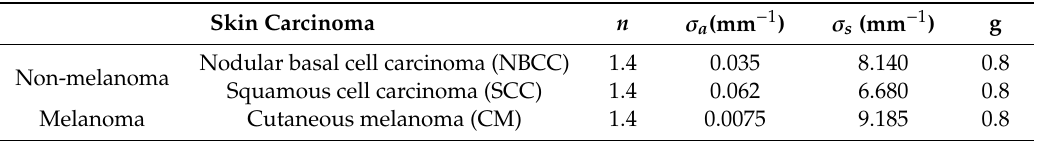
Table 3. Absorption coe ffi cient, scattering coe ffi cient and anisotropic factor of a skin lesion at 785 nm [24,25].